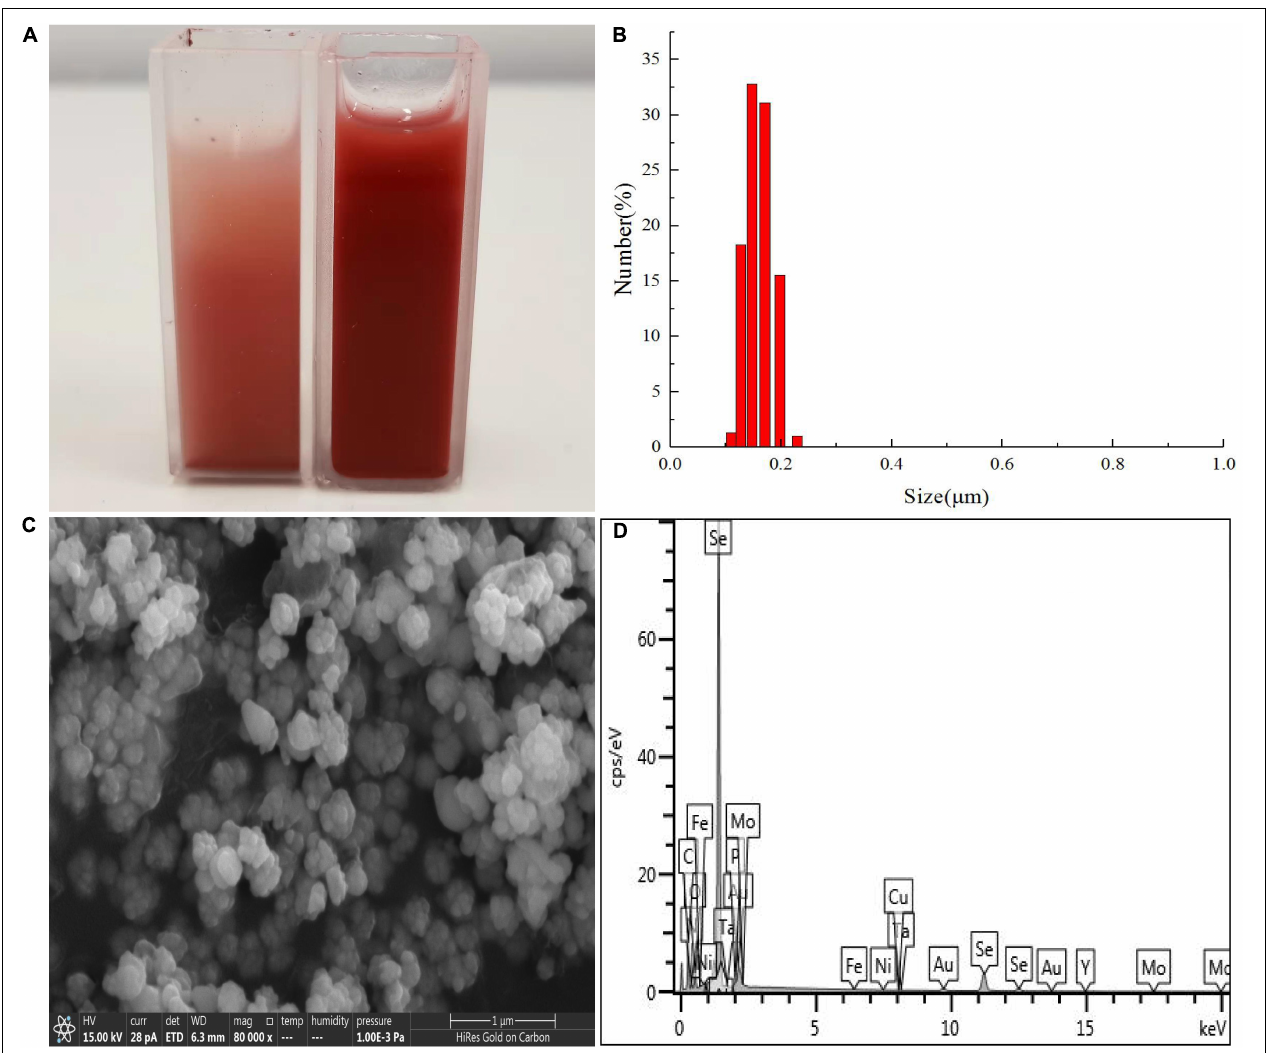
FIGURE 8 | Dynamic light scattering (DLS) spectra of purified SeNPs produced by Proteus mirabilis QZB-2 in LB supplemented with 2.0 mM selenite. (A) Selenite-dosing cells (left) and purified nano-selenium (right); (B) size distribution of purified SeNPs; (C) SEM micrographs of purified SeNPs. (D) EDX analysis of purified SeNPs showing its selenium